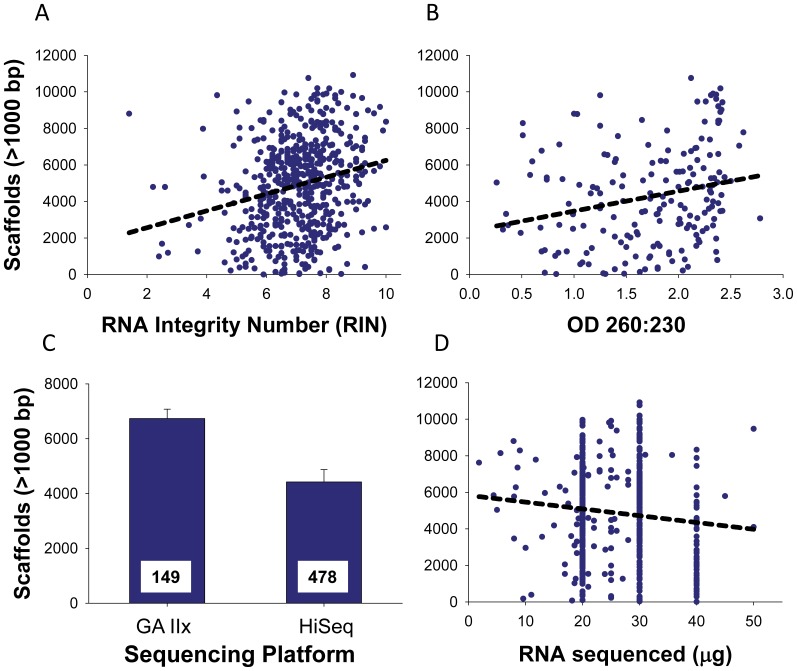
Factors that significantly predicted the number of large scaffolds.Among our measures of RNA quality, (A) RNA integrity number (RIN) and (B) OD 260/230 ratio were the strongest predictors of the number of scaffolds ≥1000 bp. (C) Sequencing platform also had a strong effect on number of large scaffolds (P<0.001, Table 2; numbers at the base of bars show sample size), and (D) mass of RNA sequenced had a weak but detectable effect (see Table 2). Note, for most samples we used 20, 30 or 40 µg of total RNA for sequencing, but a few samples used intermediate or lower amounts.